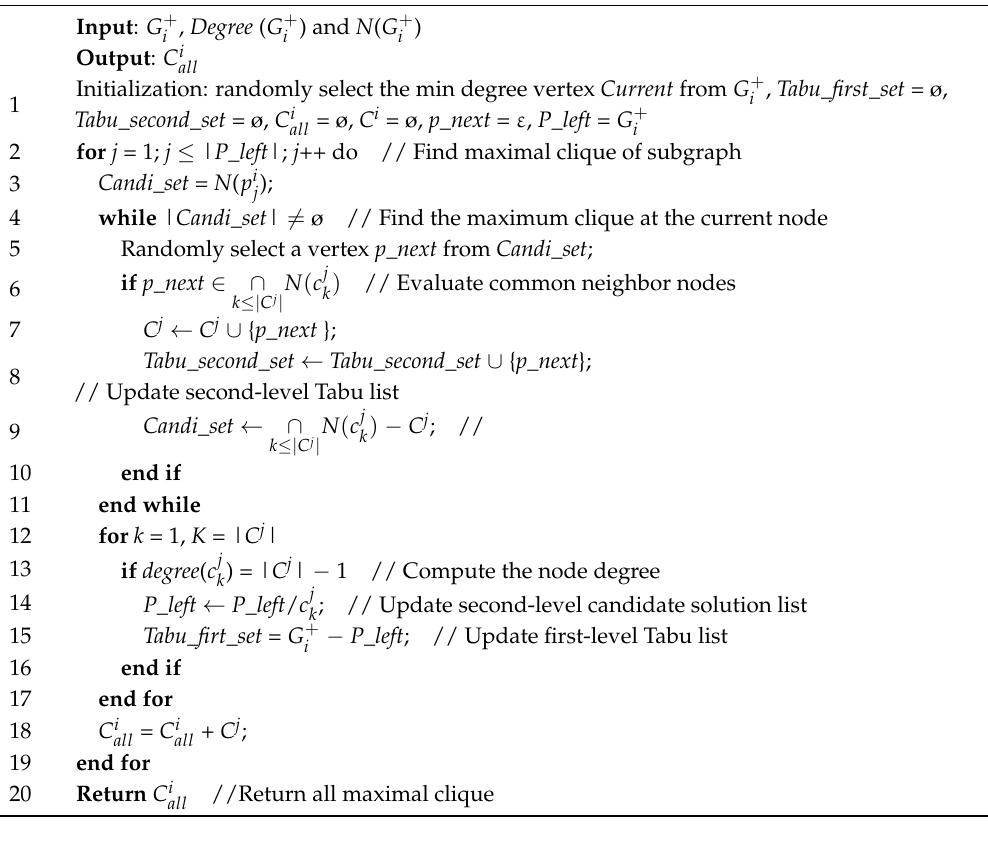
Algorithm 1: The double-layer Tabu search maximal clique (DTSMC).